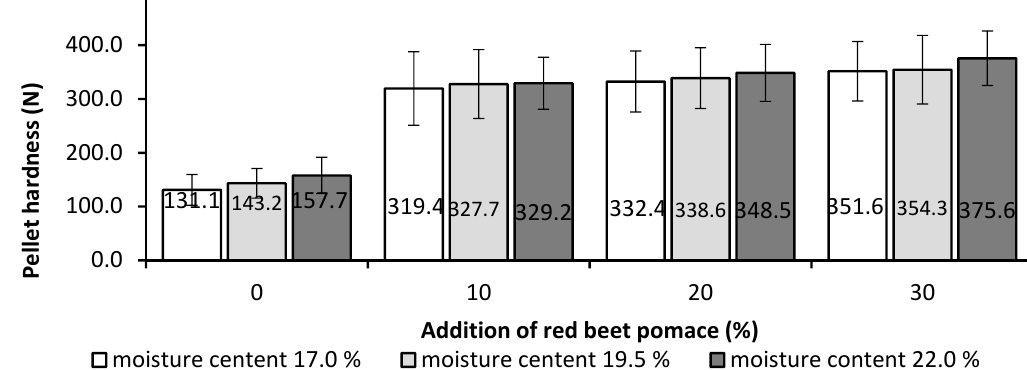
Figure 4. Influence of the contribution of red beet pomace in the mix with barley straw and mix moisture content on the hardness of the obtained pellet.